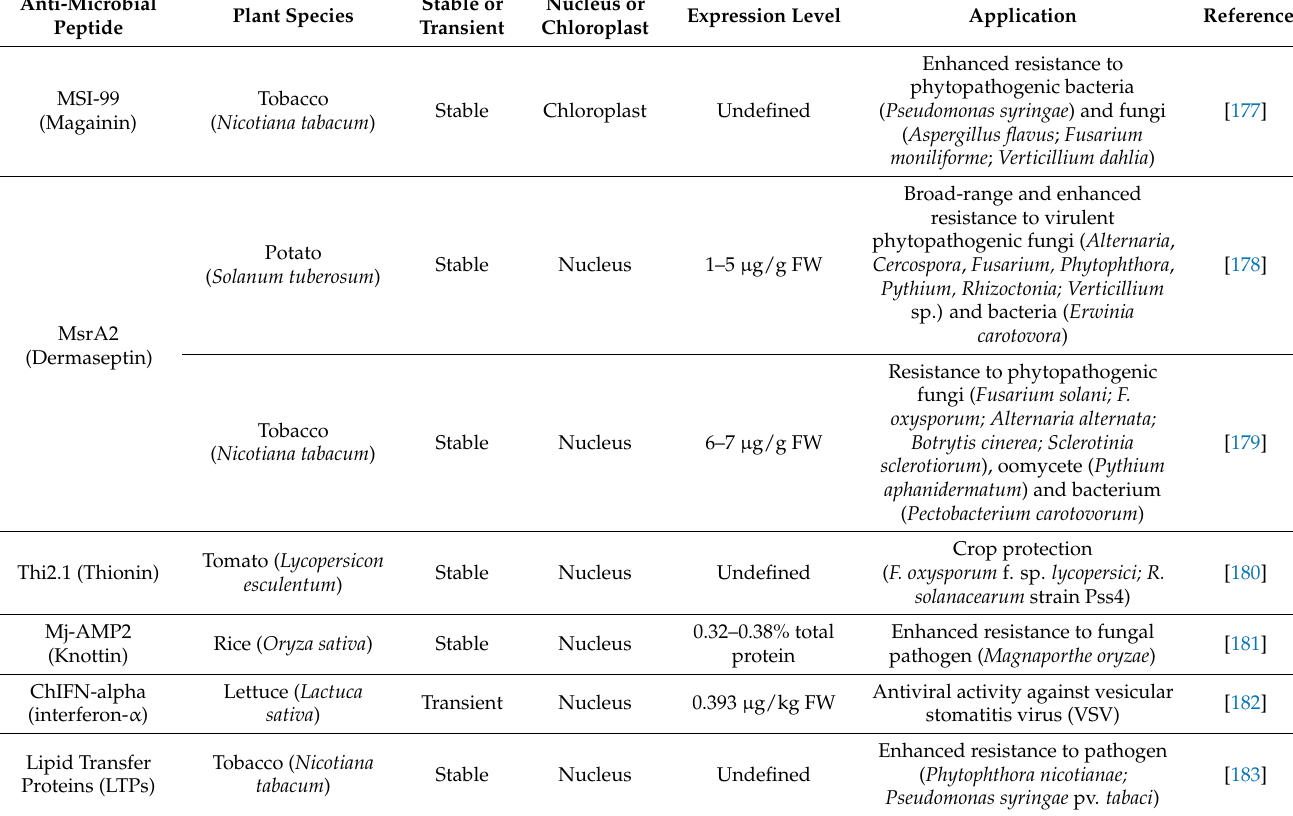
Table 3. Some of the candidate AMPs expressed in plant